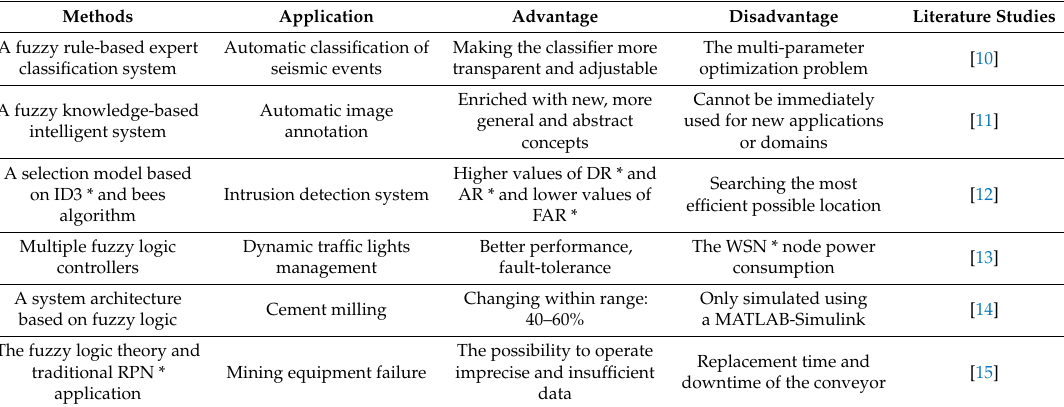
Table 2. Comparison of methods, applications and advantages about decision support